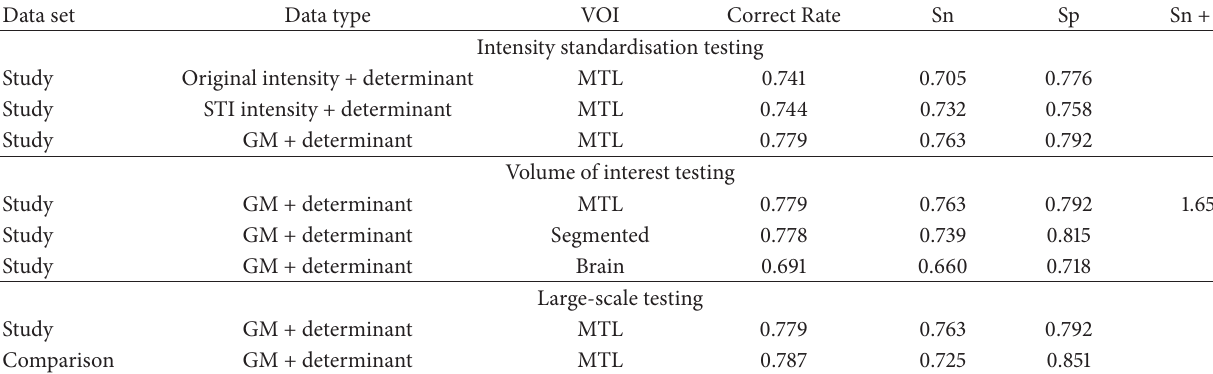
Table 2: Discrimination of controls versus probable AD.